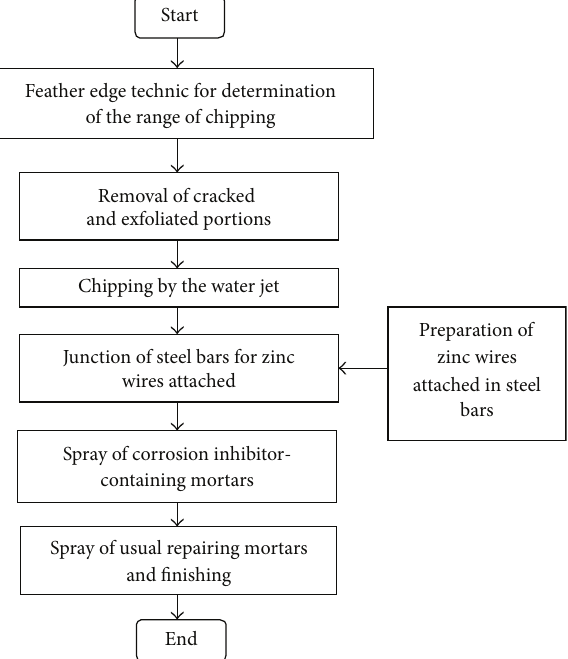
Figure 19: Flow chart of the practical works of repair.